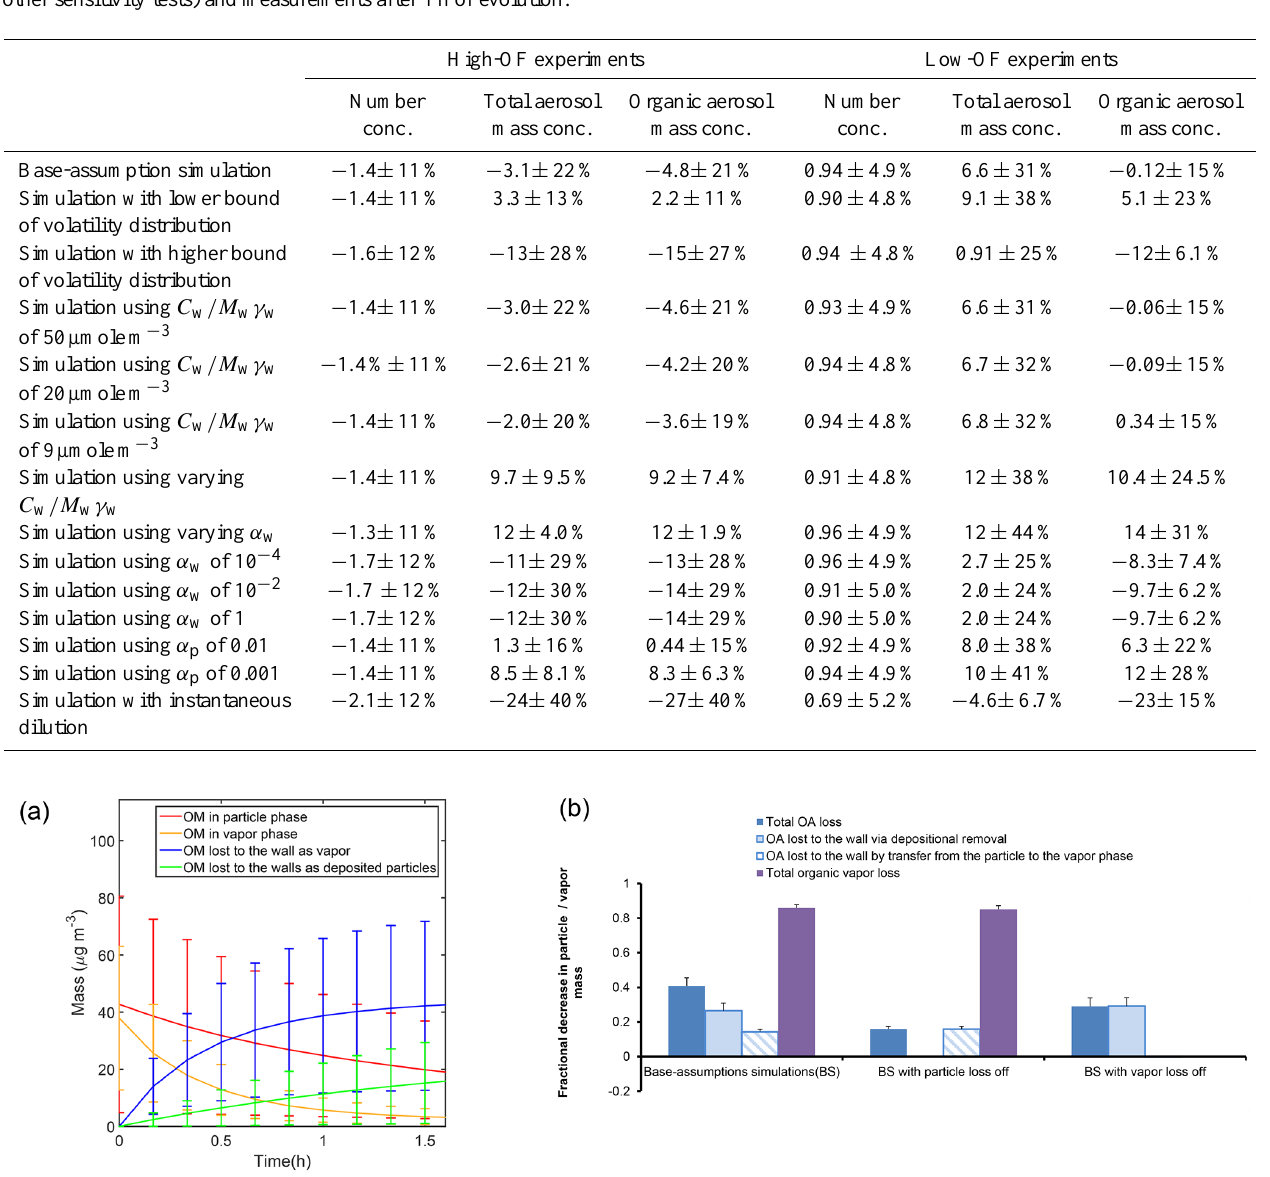
Table 5. The percent bias between the mean and the standard deviations of these simulations (including base-assumption simulation and other sensitivity tests) and measurements after 1h of evolution.